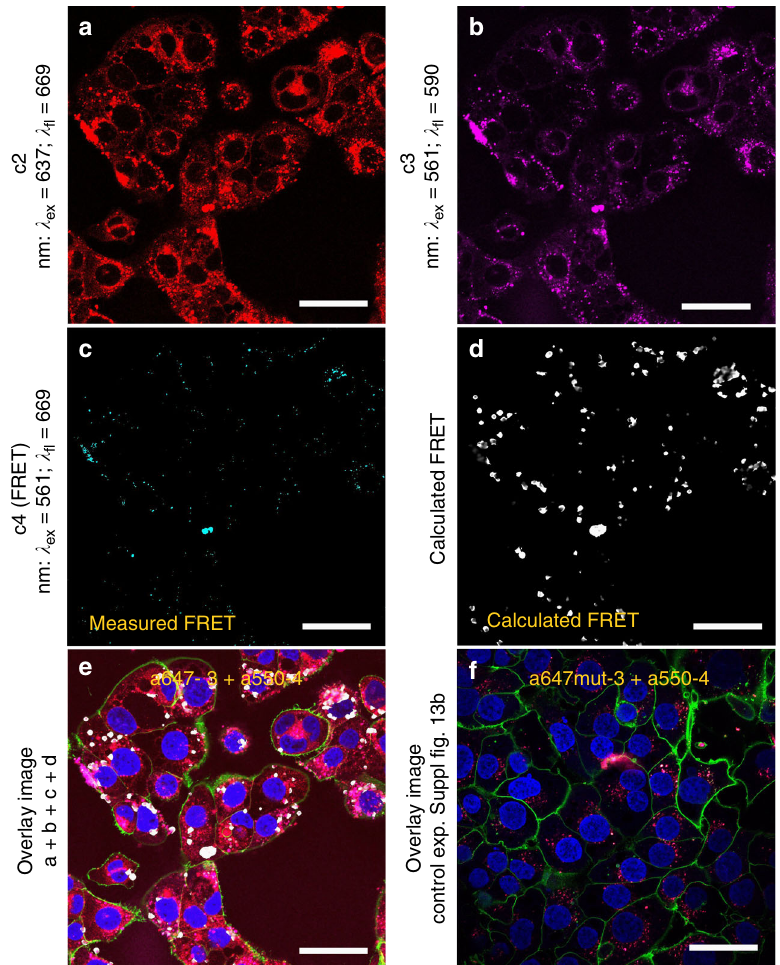
Fig. 6 Cellular uptake of dual-labeled HyApNc consisting of A550- 4 and A647N- 3 motifs. a – c Confocal fl uorescence images of H1838 cells treated with the HyApNc consisting of Atto550- DxR -L4 motif (A550- 4 ) and Atto647N-trCLN3-L4 (A647N- 3 ) motifs in 1:1 ratio. Both A647N- 3 ( a : c2: red) and A550- 4 ( b : c3: magenta) fl uorescence were observed from the cytosol including a FRET-mediated Atto647N signal ( c : c4: cyan). d Calculated FRET signal from reconstructed FRET images ( d : white) indicate the intracellular integrity of the functional nanoconstruct HyApNc. e , f Overlay images of cells incubated with HyApNc ( e : A647N- 3 + A550- 4 ), and HyApNc.mut ( f : A647N.mut- 3 + A550- 4 ) as a negative control with Atto647N-labeled mutant trCLN3.mut-L4 motif. The complete overlay sets for e and f are shown in Supplementary Fig. 19. Aptamer constructs were incubated at 37 °C for 2 h, followed by membrane staining with Alexa488-WGA (green), and nuclei staining with Hoechst 33342 (blue). Scale bar: a – f 50 µ (Fig. 5i, green area) showed signi fi cantly higher shift in fl uorescence intensity. A minimal shift in fl uorescence intensity was also observed for cells treated with either Atto647N-mut 3 (Fig. 5i, blue curve) or Atto647N- 3 at 4 °C (Fig. 5i, red curve) over untreated cells (gray areas), indicating either a low non-speci fi c binding or only a membrane localized binding without internalization at low temperature. Taken together, these results show that important determinants for ef fi cient uptake into H1838 cells are the ability to bind extracellular cMet by the aptamer moieties, the ability to form nanoconstructs due to lipidation, and